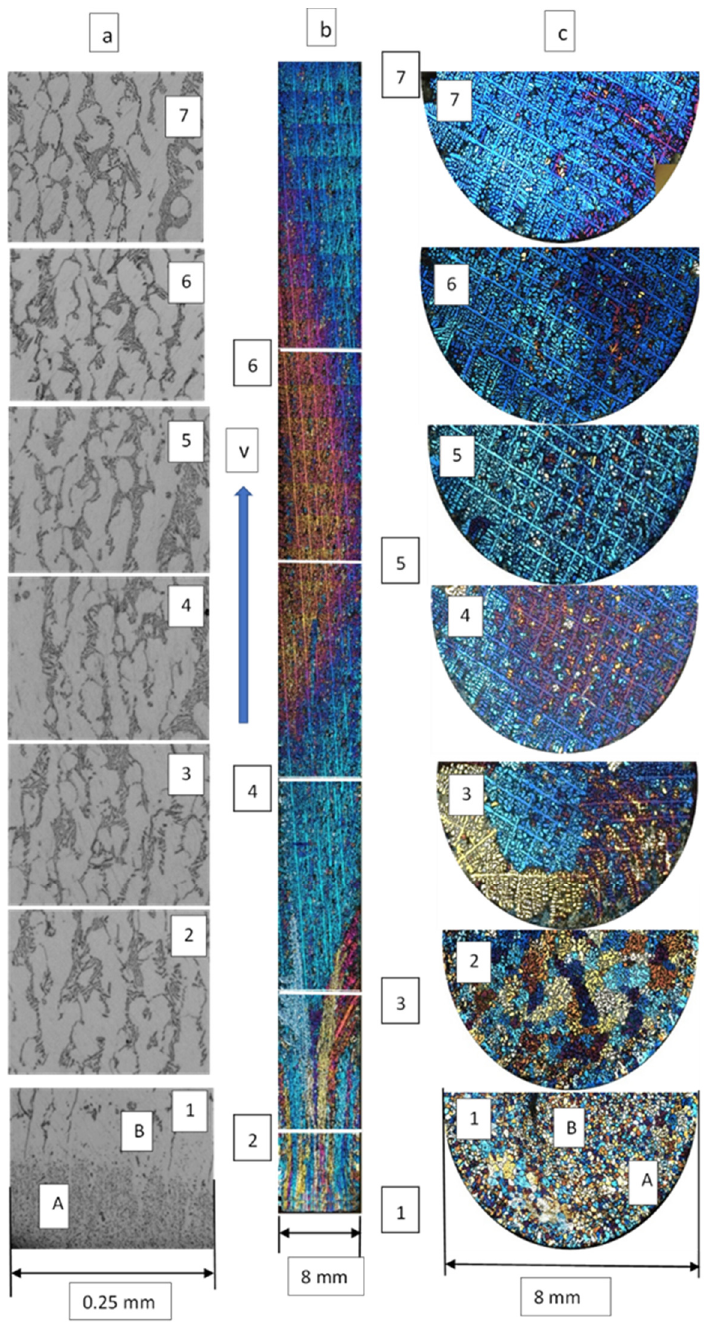
Figure 7. ( a ) Microstructure of Sample GB1-a: grain structure of the whole sample, longitudinal section; b: grain structure at the cross-section; c: dendritic structure at the longitudinal section; the blue arrow shows the direction of solidification. ( b ) Microstructure of Sample GB2; a: grain structure of the whole sample, longitudinal section; b: grain structure at the cross-section; c: dendritic structure at the longitudinal section; The blue arrow shows the direction of solidification. ( c ) Microstructure of Sample GB5; a: grain structure of the whole sample, longitudinal section; b: grain structure at the cross-section; c: dendritic structure at the longitudinal section; The blue arrow shows the direction of solidification. ( d ) Microstructure of Sample GB6; a: grain structure of the whole sample, longitudinal section; b: grain structure at the cross-section; c: dendritic structure at the longitudinal section; The blue arrow shows the direction of solidification.